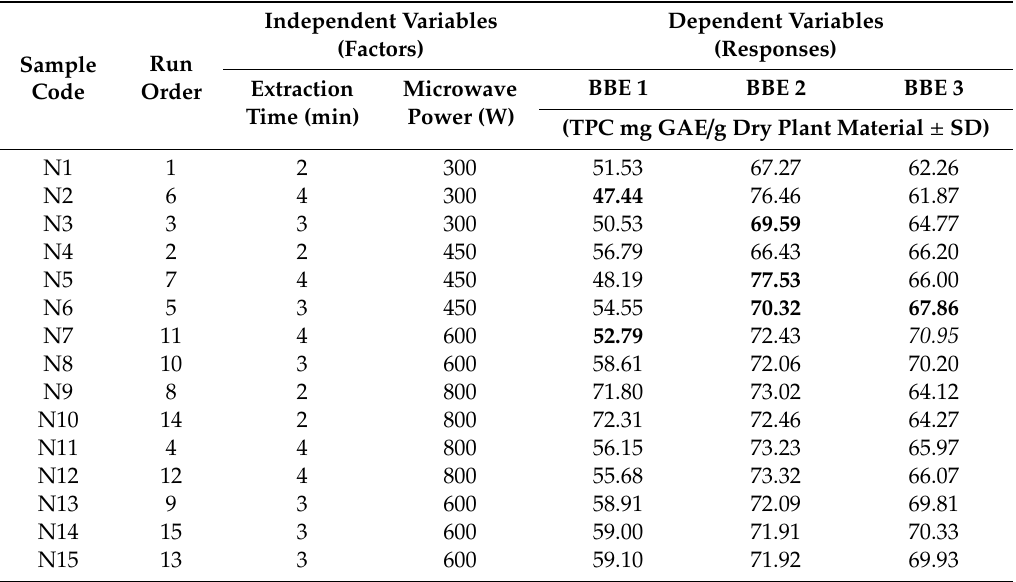
Table 2. Matrix of experimental design and experimental results for total phenolic content (TPC).